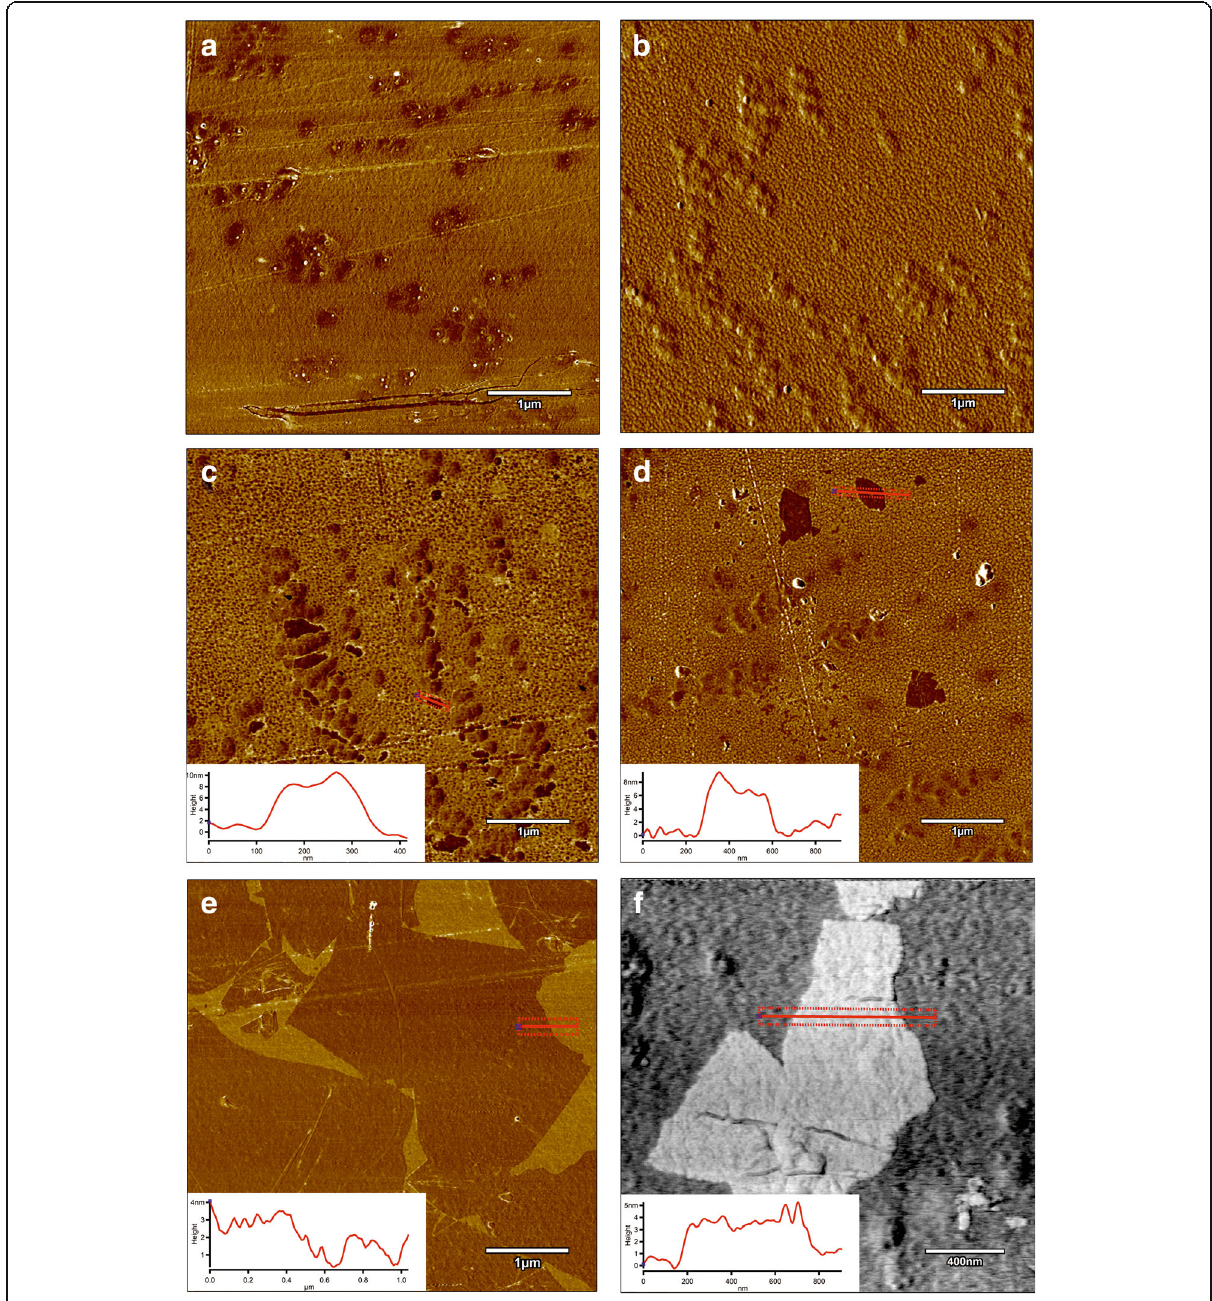
Fig. 8 AFM phase contrast images and cross sections topographic images of graphene flakes: a non-coated foil polyurethane foil; b Ag-NPs coated foil where characteristic and homogeneous grid structures are observed; c , d GO-Ag-coated foil; e GO-coated foil, the surface of the foil almost entirely covered with GO flakes; the phase contrast image helps to observe these two phases, the darker area is GO and the lighter area is polymer foil; f LFM image of graphene flake. Red marks, area of cross